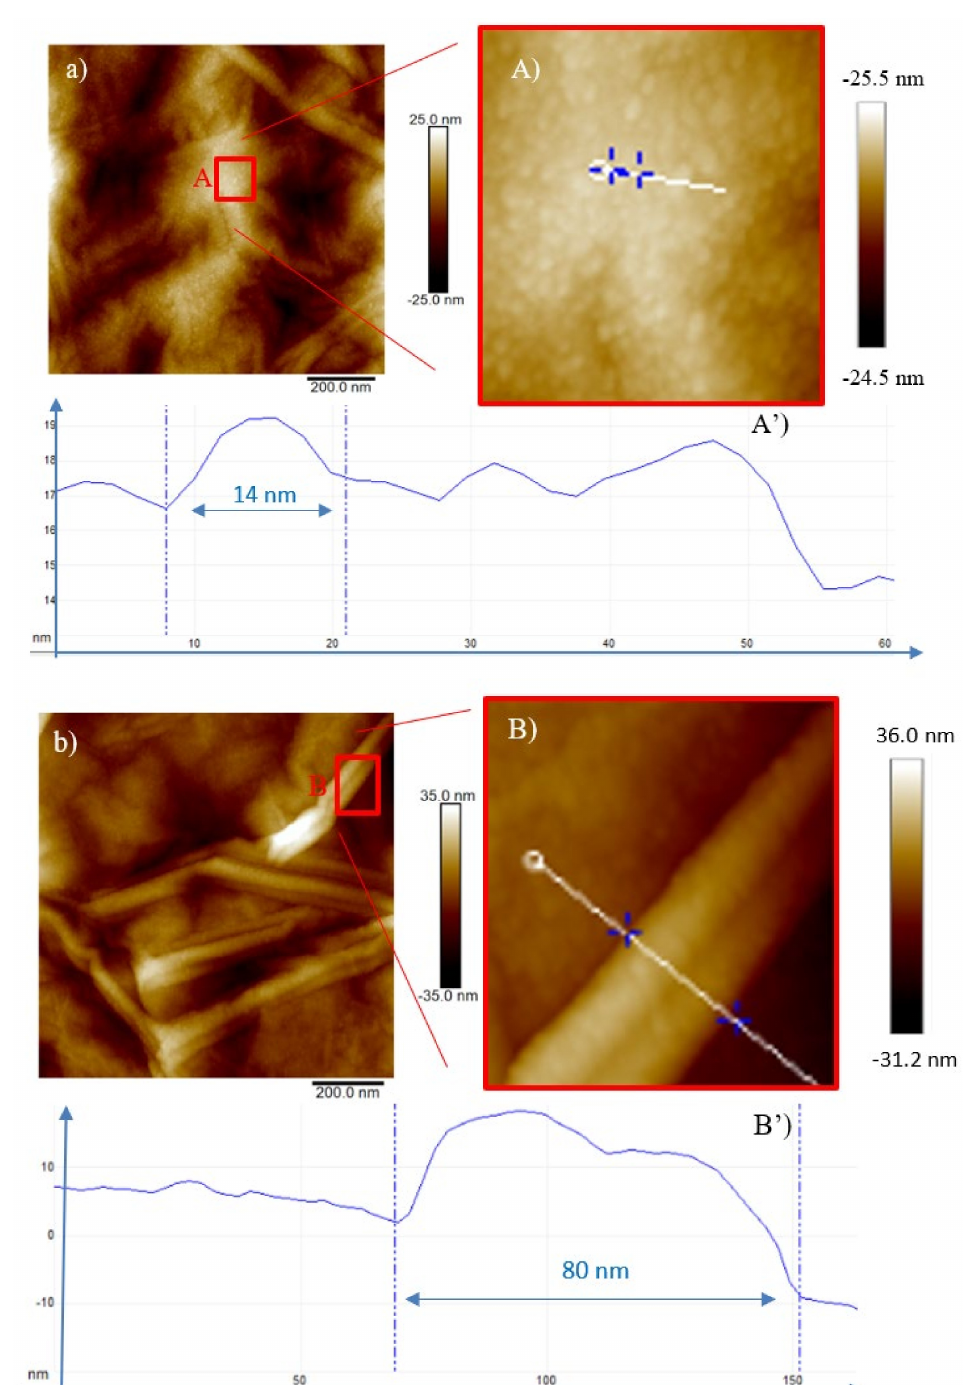
Figure 7. Two-dimensional AFM images of GO irradiated by the 3 MeV He + ions at: the 5 × 10 13 ions/cm 2 fluence ( a ), magnified area of the red square ( A ) and profile of the selected structure ( A’ ) and at the 5 × 10 14 ions/cm 2 fluence ( b ), magnified area of the red square ( B ) and profile of the selected structure ( B’